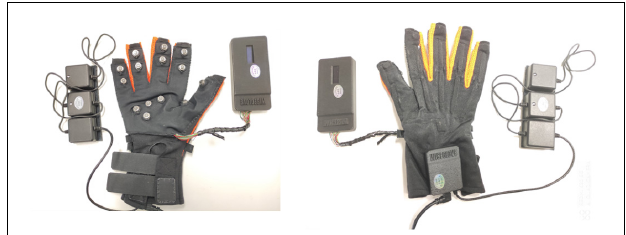
FIGURE 2 | Wiseglove14 data glove.